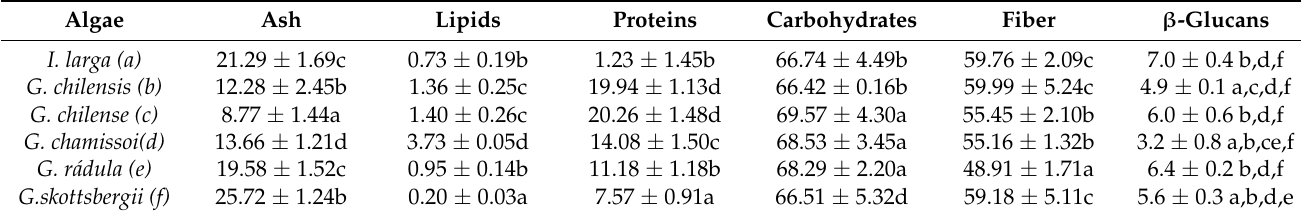
Values correspond to the average of triplicates ± standard deviation. Letters indicate significant differences ( p < 0.05). Proteins were estimated by converting nitrogen content using a factor of 6.25. Total carbohydrates were estimated as the difference of subtracting 100 other components (i.e., lipids, minerals, proteins,